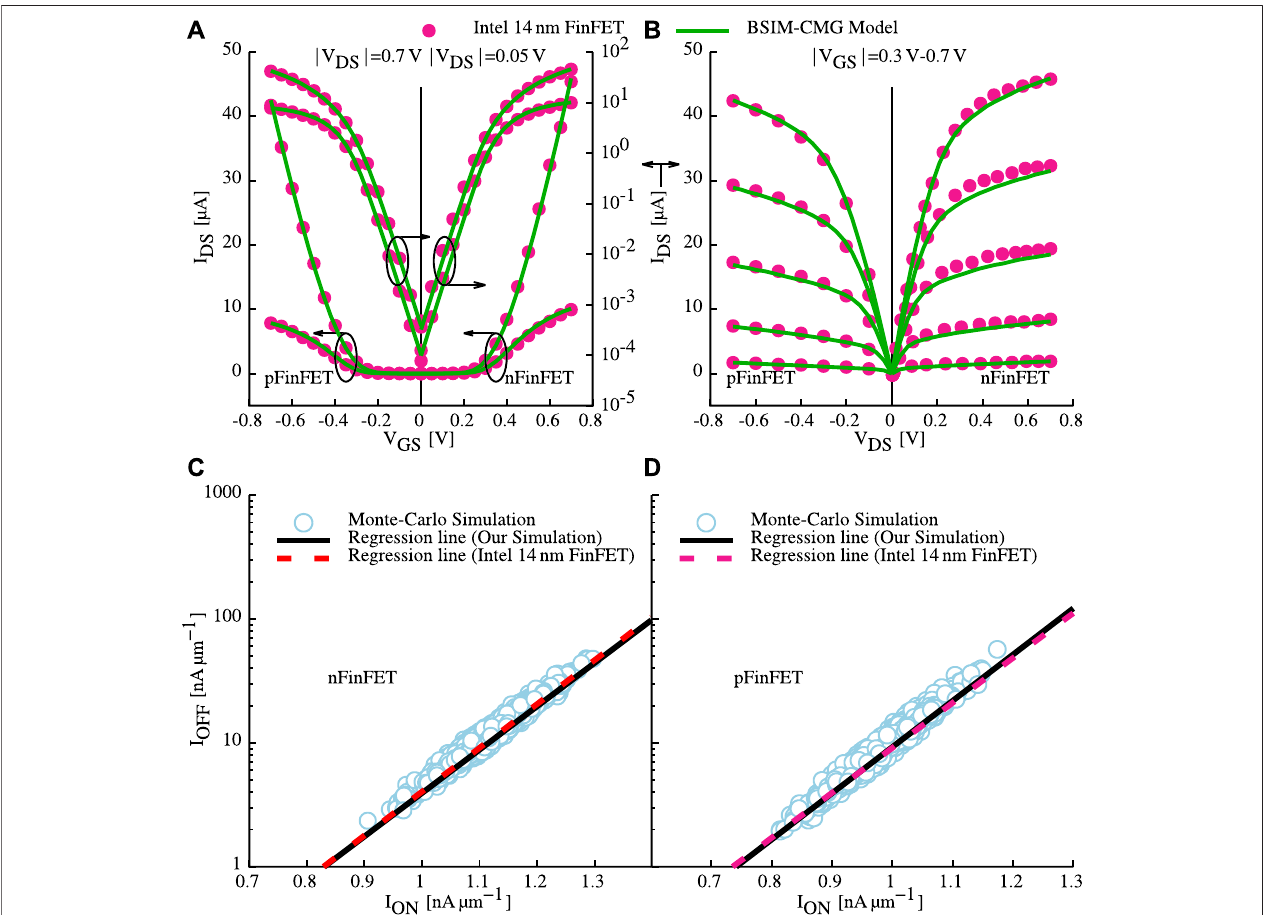
FIGURE 7 | Calibration and validation of the compact model against Intel 14 nm FinFET measurements extracted from Natarajan et al. (2014). For all different biasing conditions both nMOS and pMOS are considered (A,B) . Similarly, variability is validated against Intel 14 nm FinFET, again for nMOS and pMOS in (C,D) , respectively. Details on device and variability calibrations are available in \cite{TCASI20_2} Amrouch et al. (2020).